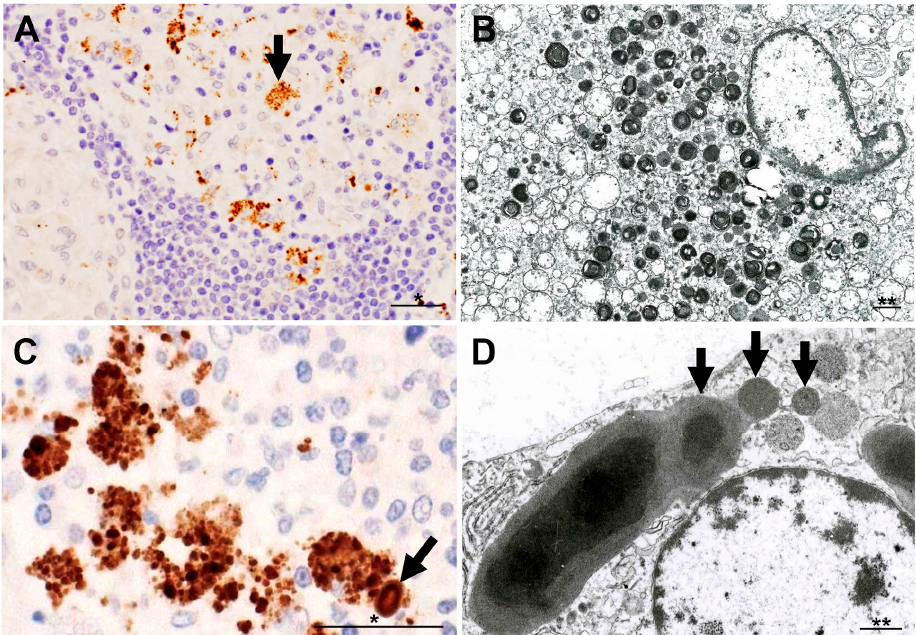
Figure 3. Morphologic features of intracellular P. acnes proliferation in sarcoid lymph nodes. Most of the PAB-reactive P. acnes in granuloma cells, such as indicated by an arrow ( A ), are degraded showing lamellar body formation ( B ). Intracellular proliferation of P. acnes is suggested in an early focus of paracortical granuloma composed of a cluster of swollen macrophages filled with many PAB-reactive small round bodies with a similarly PAB-reactive Hamazaki–Wesenberg (HW) body (an arrow) ( C ). HW bodies are found mainly in sinus macrophages rarely accompanied by small round bodies (arrows) sprouting from the large ovoid HW body ( D ). All photos are original. Scale bar: * 50 μ m, ** 1 μ m.